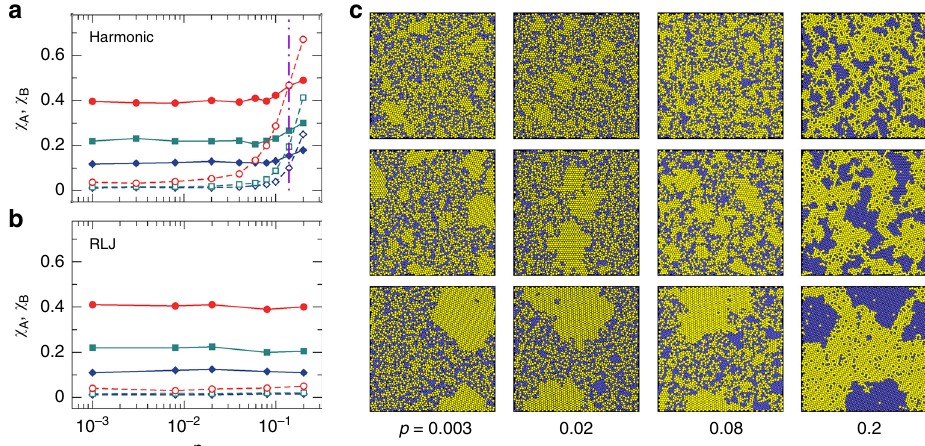
Fig. 1 Pressure and quench rate dependence of the glass-forming ability. a , b are for harmonic and RLJ systems, respectively, with γ = 1.4, c B = 0.5, and ~ κ ¼ 8 : 16 ´ 10 (cid:2) 11 , 8.16 × Δ = 0. The solid and empty symbols are χ χ A and B , respectively. Circles, squares, and diamonds are for dimensionless quench rate 10 − 10 , and 8.16 × 10 − 9 , respectively. The lines are guides for the eye. The vertical dot-dashed line in a shows the crossover pressure p n ≈ 0.14 (also shown in Fig. 2a for comparison), at which the melting temperatures of A and B particles intersect and χ A is approximately equal to χ B , as discussed in the text. c Snapshots of solid-like states for harmonic systems. From top to bottom, ~ κ decreases. From left to right, pressure p increases with the values being shown at the bottom. The yellow and blue disks are A (large) and B (small) particles. To distinguish particles, we have moderately decreased the particle diameters by 10 –